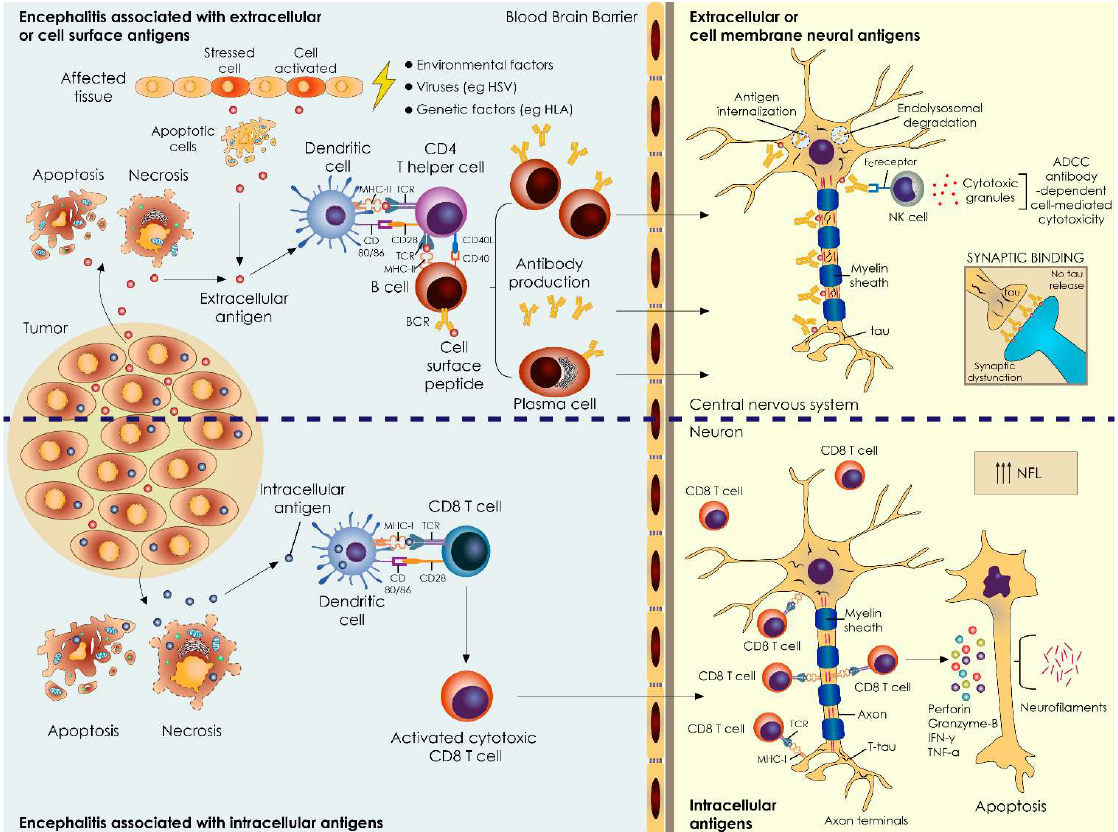
Figure 3. General principles of immune-pathogenesis of paraneoplastic and non-paraneoplastic autoimmune encephalitic syndromes and the role of neuronal and neuroaxonal damage biomarkers. The presence of tumor is more commonly found in autoimmune encephalitis associated with intra- cellular antigens ( lower panel ). Autoantigens expressed or released (either after apoptotic or necrotic cell death) by tumor cells are thought to initiate an autoimmune response especially after being captured by antigen-presenting cells (APCs) (e.g., dendritic cells) in peripheral lymphoid tissue ( lower panel ). In the absence of a tumor, the underlying pathology is obscure and the most common triggering factors are thought to be a viral infection or genetic/environmental factors af- fecting tissue homeostasis ( upper panel ). Extracellular antigens are processed and presented by APCs to CD4+ helper T cells in the context of MHC II molecules and fully activate B cells. B cells differentiate in antibody-producing plasma cells. B cells, plasma cells and IgG autoantibodies enter the central nervous system through a leaky blood–brain barrier. IgG autoantibodies have the potential to cause synaptic autoimmune disorders directly through antigen internalization, complement activation, antibody-dependent cell cytotoxicity (ADCC) and receptor blocking ( upper panel ). Intracellular antigens processed by APCs, in the context of MHC class I molecules and in the presence of a pro-inflammatory cytokine milieu, favor the activation of cytotoxic CD8+ effector T cells. Cytotoxic CD8 T cells invade the CNS to exert cellular neuron-directed autoimmunity via the release of perforin and granzyme B, leading to the apoptosis of the target cells ( lower panel ). CSF-NFL levels are elevated in cases of encephalitis associated with the presence of an underlying tumor, where cytotoxic CD8 T causes more destructive effects in the affected tissue ( lower panel ). CSF-NFL and tau are not elevated in patients with encephalitis associated with extracellular antigens, possibly reflecting less destructive effects of autoantibody-mediated neuroaxonal injury (e.g., dysfunction of neuronal synapsis, indicative of distinct antibody-mediated effects) ( upper panel ). APC = antigen-presenting cells; HLA = human leukocyte antigen; MHC = major histocompatibility complex; ADCC = antibody-dependent cell cytotoxicity; NFL = neurofilament, HSV = herpes simplex virus; BCR = B cell receptor, TCR = T cell receptor.